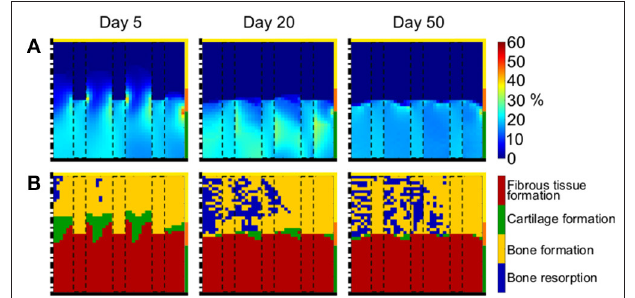
FIGURE 8 | Mechanical environment of the defect region with grid-like scaffold. (A) Distribution of γ ; (B) prediction of tissue formation based on S. Left, middle, and right columns show results at day 5, 20, and 50, respectively. The scale bars to interpret the plots are on the left side of the corresponding rows. The black dash-dot lines and the black solid lines mark the axis of symmetry and the articular interface, respectively. The colors of the borders indicate the neighboring tissues in the FE model of the femoral condyle: yellow, orange, and green stand for cancellous bone, subchondral bone, and cartilage, respectively. The black dashed lines mark the struts of the